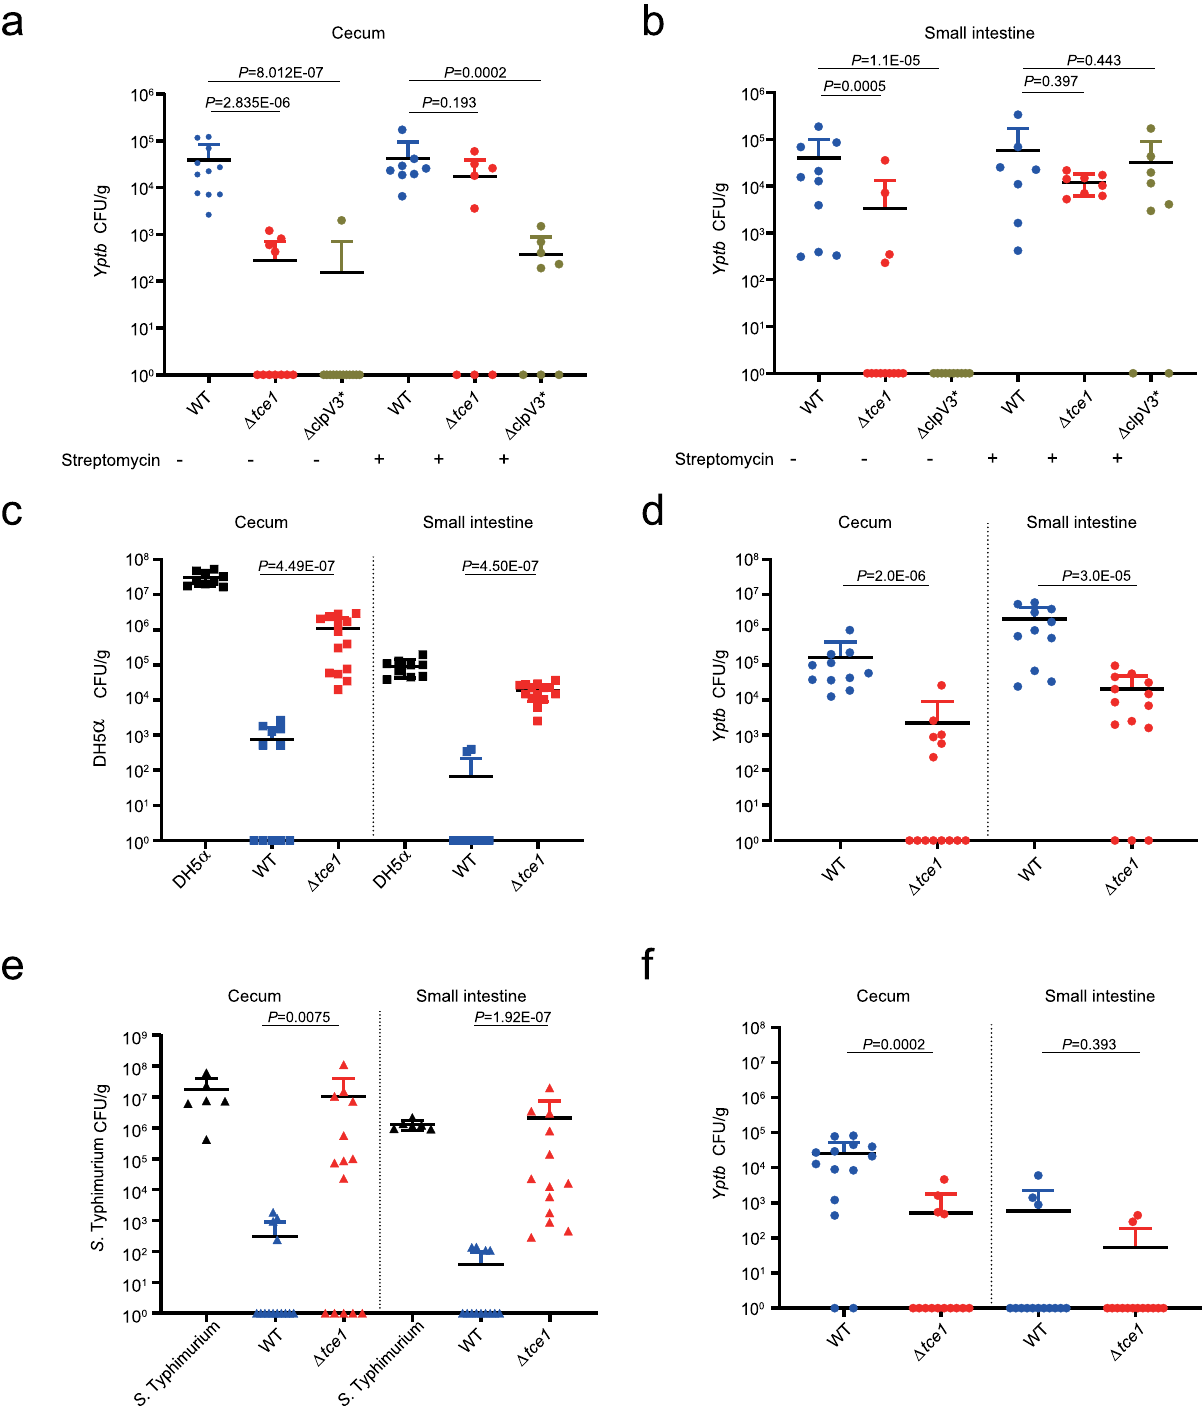
Fig. 5 The Tce1-mediated T6SS killing pathway facilitates Yptb colonization of the mouse gut. a , b Mice with and without streptomycin pre-treatment in a (Strep-: WT n = 11; Δ tce1 n = 11; Δ clpV3* n = 13 and Strep + : WT n = 8; Δ tce1 n = 8; Δ clpV3* n = 8) and b (Strep-: WT n = 10; Δ tce1 n = 13; Δ clpV3* n = 10 and Strep + : WT n = 7; Δ tce1 n = 8; Δ clpV3* n = 8) were orally gavaged with 10 9 CFUs of the indicated Yptb strains. Animals were sacri fi ced 24 h after bacterial challenge, and bacterial loads in cecum ( a ) and small intestine ( b ) were measured. c , d Streptomycin-treated mice ( n = 9 – 14) were colonized with 5 × 10 8 CFUs of E . coli for 24 h and then challenged with 5 × 10 8 CFUs of WT Yptb , Δ tce1 or buffer control (buffer control: n = 9; WT: n = 11; Δ tce1 : n = 14). Animals were sacri fi ced 24 h after the challenge, and surviving E . coli ( c ) and Yptb ( d ) in the cecum and small intestine were counted. PBS mixed with E . coli was used as the negative control. e , f Streptomycin-treated mice were gavaged with a 1:1 mixture of S . Typhimurium and WT Yptb or Δ tce1 mutant (buffer control: n = 6; WT: n = 14; Δ tce1 : n = 14). Animals were sacri fi ced 8 h after the challenge, and CFU of S . Typhimurium ( e ) and Yptb ( f ) in the cecum and small intestine were counted. PBS mixed with S . Typhimurium was used as the negative control. Each data point represents result from one mouse; error bars represent mean ± SD of recovered CFUs. Statistical analysis of all experiments was carried out using the two-sided Mann – Whitney test. Differences were determined as signi fi cant when P <